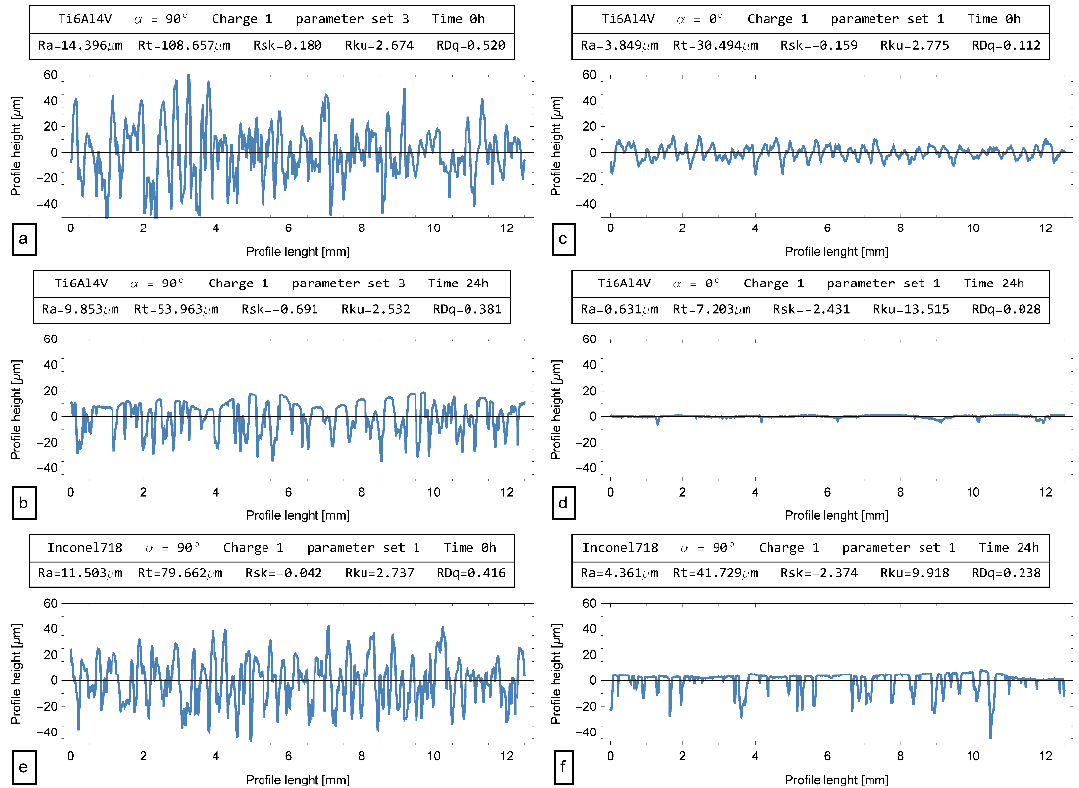
Figure 9. Roughness profiles before and after BF operation with charge 1 and parameter set 3 for Ti6Al4V vertical surfaces (a, b), for Ti6Al4V horizontal surface with parameter set 1 (c, d), for Inconel718 vertical surfaces with parameter set 1 (e, f).